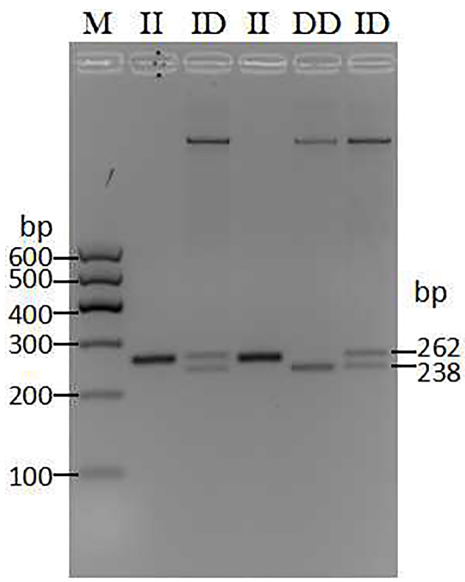
Figure 1. The agarose gel electrophoresis patterns of the 24bp in- del within the cattle AR gene. PCR products showed two genotypes at this locus where the insertion–insertion type (II genotype) con- sisted of 262bp, deletion–deletion types (DD genotype) consisted of 238bp, and the heterozygote type (ID genotype) showed 262 and 238bp, which were detected by 2.5% agarose gel electrophoresis. M: maker I (600, 500, 400, 300, 200, and